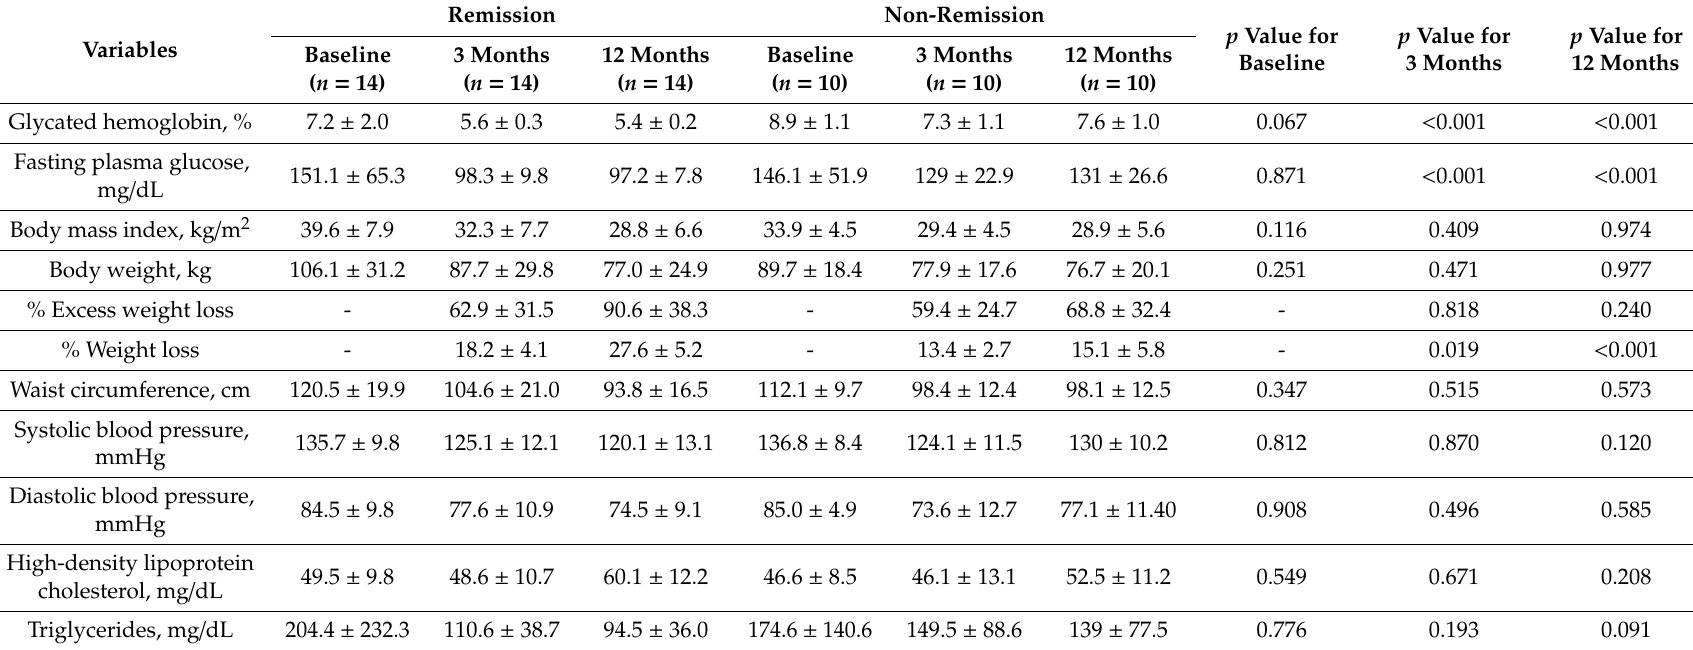
Table 2. Average values and percentage changes at 3 and 12 months after bariatric